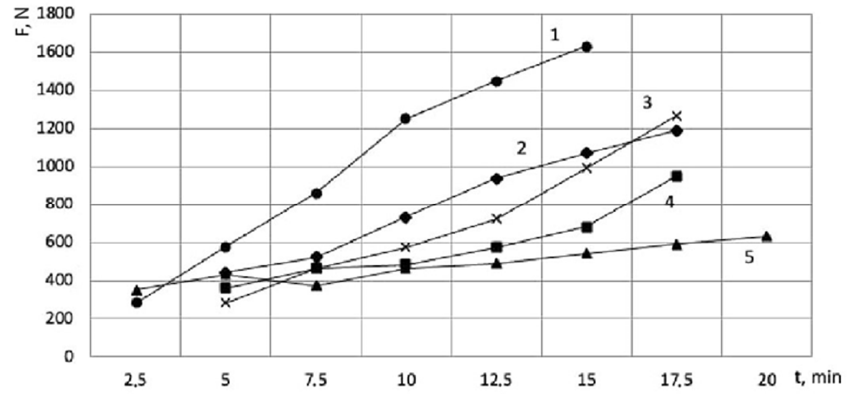
Figure 5. Graph of the dependency of cutting forces vs. the rake angle of the cutter: 1— γ = 12°; 2— γ = − 7 °; 3— γ = 8°; 4— γ = 0°; 5— γ = 4°.